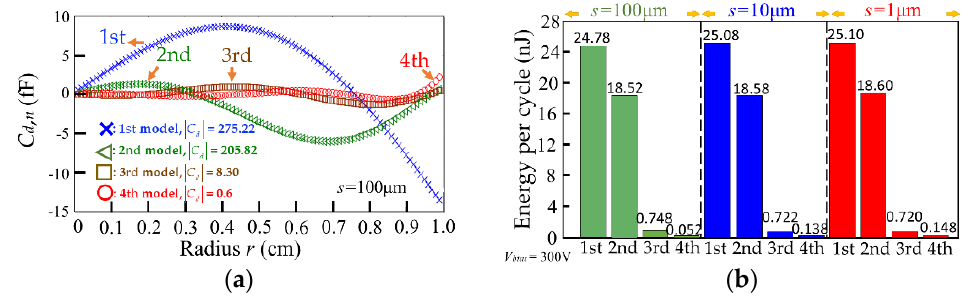
( b ) Figure 7. ( a ) The capacitance per unit longitudinal length C n ( C in + C out ) and ( b ) the capacitive vari- ation in the electrical rings ( C d , n ) along radius of membrane for the 1st mode at the gaps s = 100, 10, and 1 μ m. Concerning the modal shape, we obtain the capacitive variation in the electrical rings along the radius of the membrane in 1st–4th mode with s = 100 μ m (see Figure 8a). It is found that the amplitude of the C d , n decreases with increasing modes. We also notice that the C d , n can have positive and negative values at any given moment during vibration, as shown in Figure 8a. In addition, with Equation (12), the energy output per cycle for the three types of energy harvester can be calculated. Figure 8b shows the results that the energy outputs for the three types of rings of s = 100, 10, 1 μ m are similar, and the energy output greatly decreases in the 3rd and 4th modes due to smaller deformation. We see that all of the energy per cycle falls within the range of 0.052–25.10 nJ, which indicates that the energy output is independent of the gap size. As stated above, under each mode,